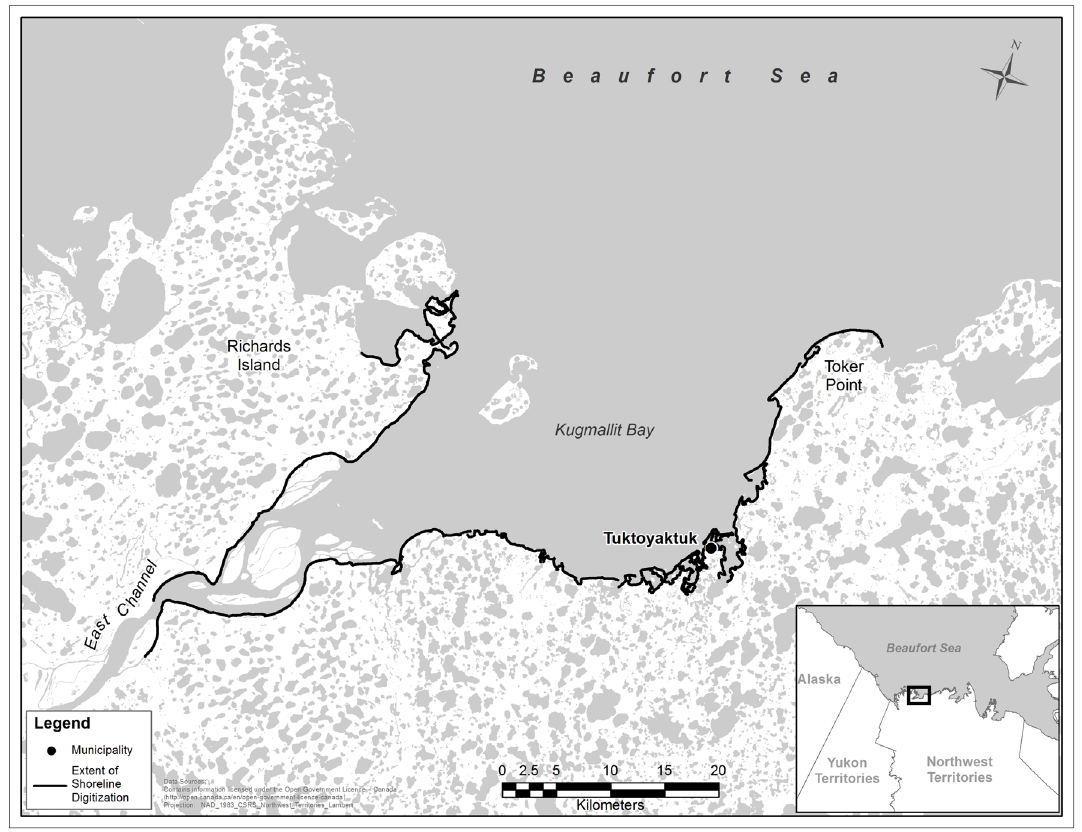
Fig. 3: Extent of shoreline digitization